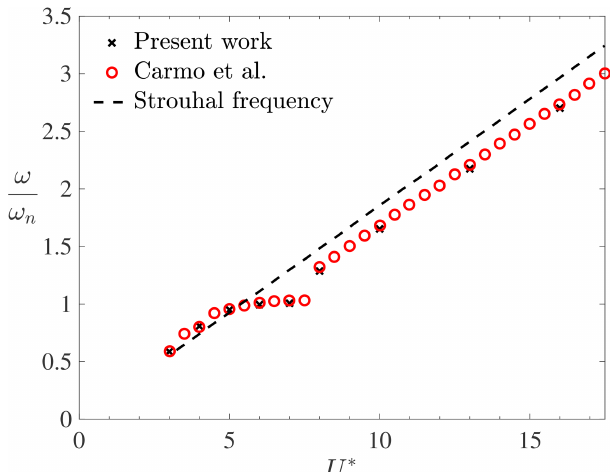
Figure 5. Ratio of the motion frequency to the natural frequency as a function of the reduced velocity for Re = 150, m ∗ = 2, and ζ = 0 .